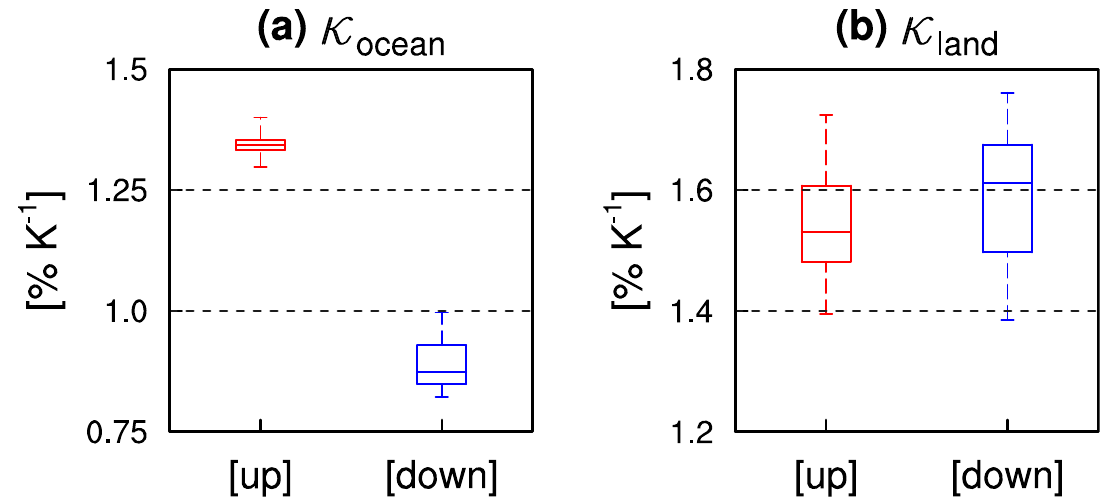
Fig. 3 Ocean and land hydrological sensitivity for each ensemble member. a Box-and-whisker diagram of apparent ocean hydrological sensitivity ( κ ocean ) during CO 2 ramp-up and ramp-down periods. The box plot and whiskers represent quartiles with median and total range, respectively, in each period. b Same as a , except apparent land hydrological sensitivity ( κ land ).